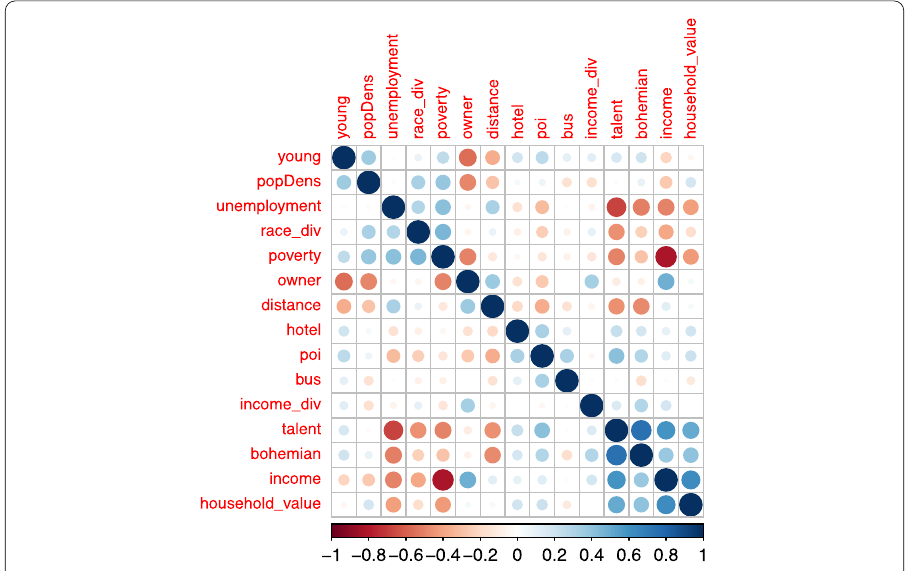
Figure 3 Pairwise Spearman correlation between explanatory variables for the eight considered U.S.